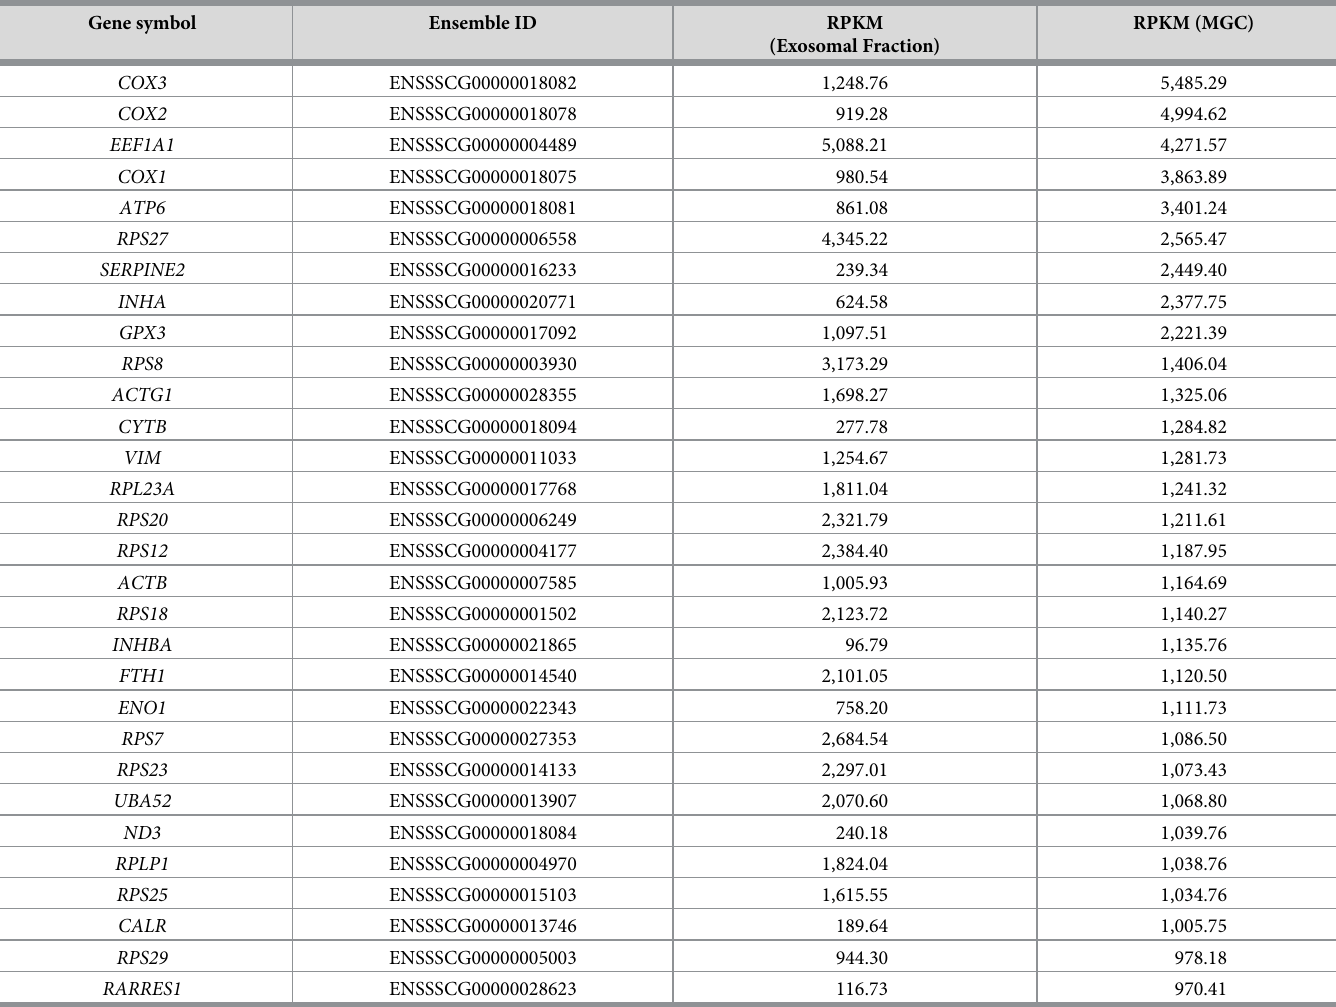
Table 2. Top 30 most abundant mRNAs in porcine